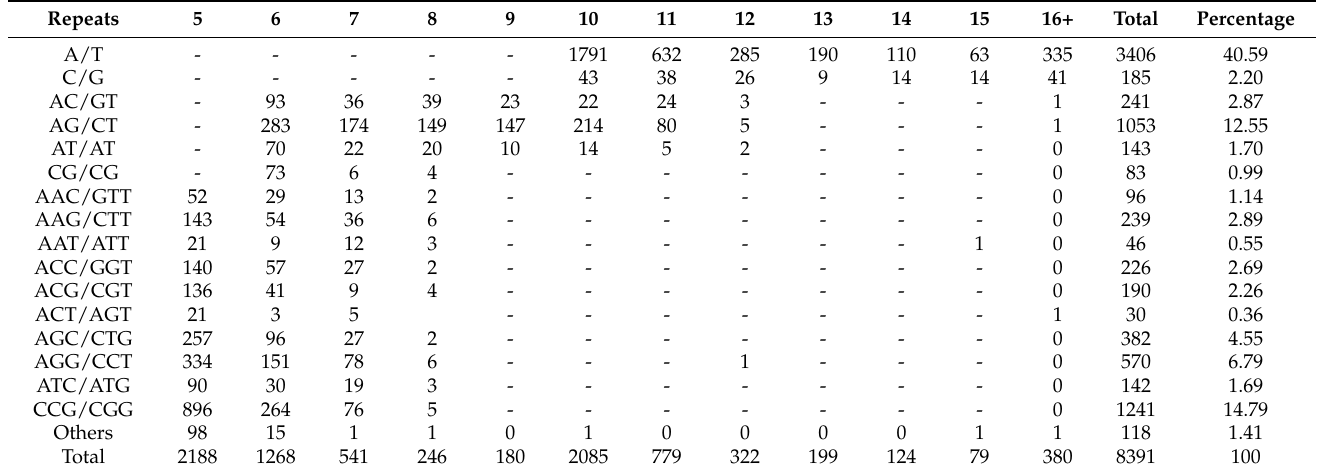
Table 2. Frequencies of different repeat motifs in SSRs in E. indica .